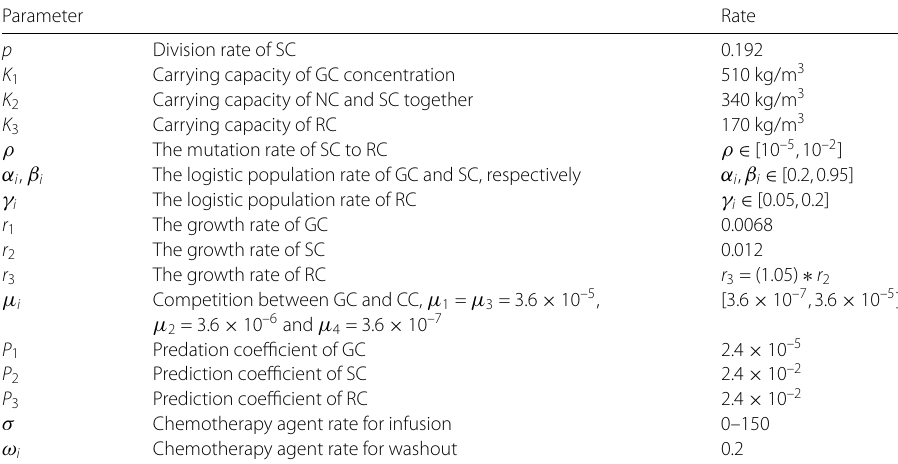
Table 1 Description of the parameters according to the literature [14]